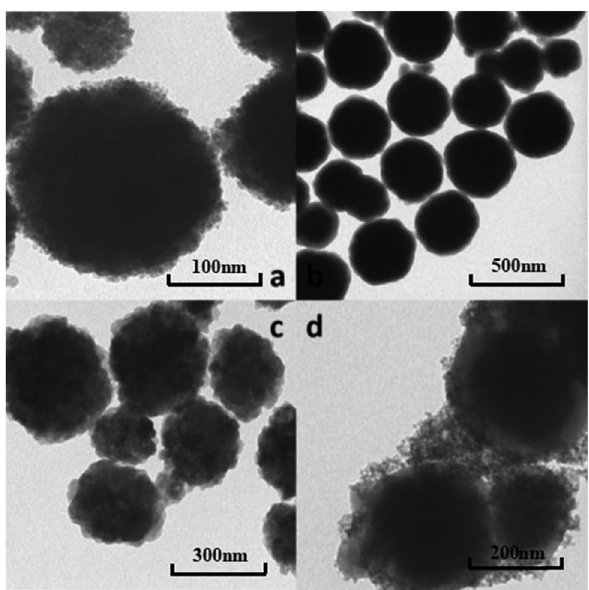
Figure 2: TEM characterization: ( a ) Fe 3 O 4 ; ( b ) Fe 3 O 4 @SiO 2 ; ( c ) Fe – ZnO; ( d ) Fe – ZnO. ( Zinc chloride was used as 3 O 4 3 O 4 @SiO 2 zinc source ) .